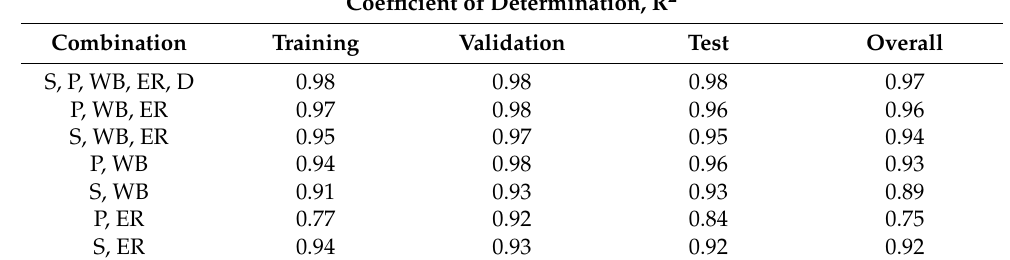
Table 8. Coefficient of determination values (R-squared values, R 2 ) of training results from artificial neural network (ANN) training for all experimental data.